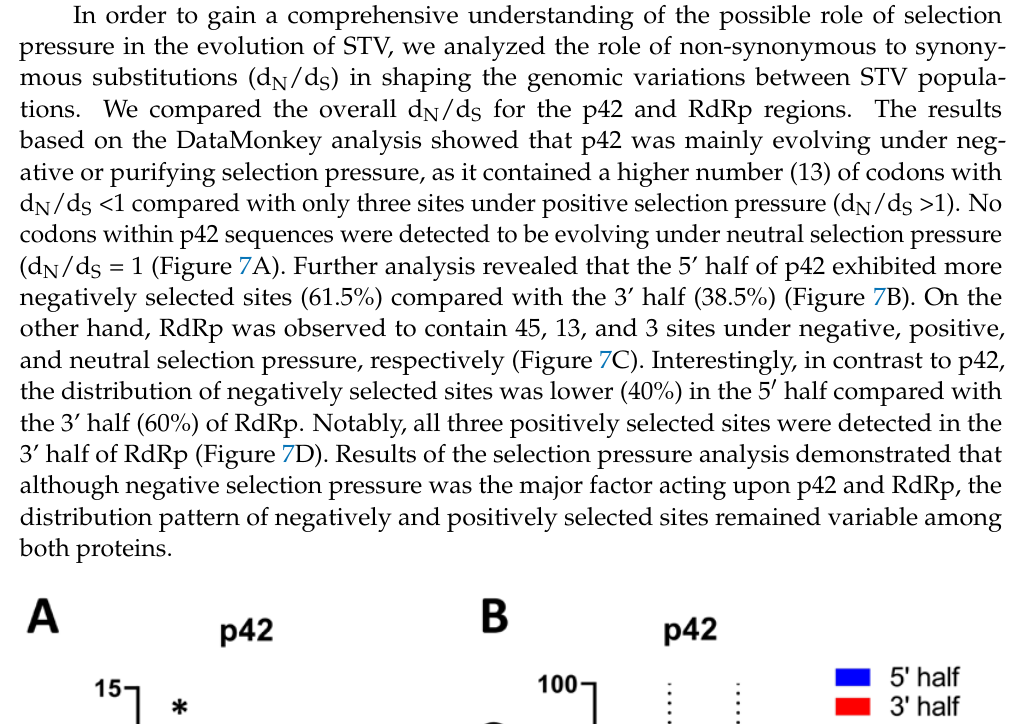
Figure 7. Estimation of positive (dN/dS > 1), negative (dN/dS < 1), and neutral (dN/dS = 1) selection acting upon codons of the major STV proteins (p42 and RdRp). ( A ) number and ( B ) percent distri- bution of p42 codons under positive, negative and neutral selection pressure, ( C ) number and ( D ) percent distribution of RdRp codons under positive, negative and neutral selection pressure. The * indicates that these sites were selected at the significance level of p < 0.1. 4. Discussion All kinds of cellular life forms are vulnerable to being parasitized by several diverse viruses, leading to multifaceted intra-host virus–virus interactions and evolution. STV is a persistent quarantine pathogen that spreads vertically through tomato seeds, infecting tomato plants without exhibiting obvious symptoms under a single infection condition, but in association with TYLCV, ToCV, TICV, TSWV, and ToMV, provokes ToYSD, exac- erbating chlorotic, leaf yellowing, stunting, and fruit deformation symptoms (Figure 1B,C) [8–13]. In this study, for the first time, we conducted large-scale STV infection diagnosis